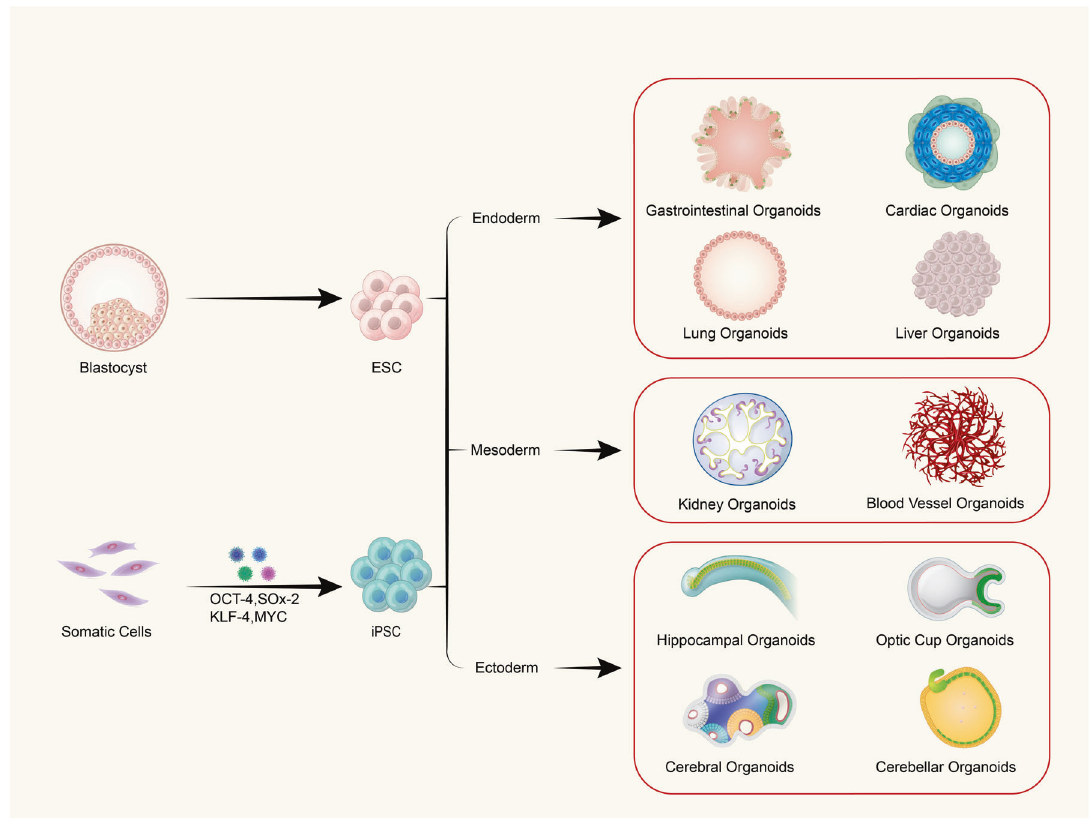
Fig. 1 Schematic of the different organoids that can be derived from PSCs. Schematic depiction of different approaches for organoid generation. Embryonic stem cells (ESCs) and induced pluripotent stem cells (iPSCs) are explored for research use. Somatic cells can be reprogrammed into iPSCs by introducing four transcription factors. As development proceeds, blastocysts differentiate into ESCs and further form all three germ layers: the endoderm, mesoderm, and ectoderm. The embryonic endoderm then generates the gastrointestinal system, heart, lungs, and liver. The mesoderm develops into the kidneys and blood vascular system, while the ectoderm forms the neural ectoderm, which eventually becomes the brain with its different regions, including the hippocampus, optic cup, cerebellum, and others. 3D organoid technology can recapitulate all the aforementioned structural and functional features in